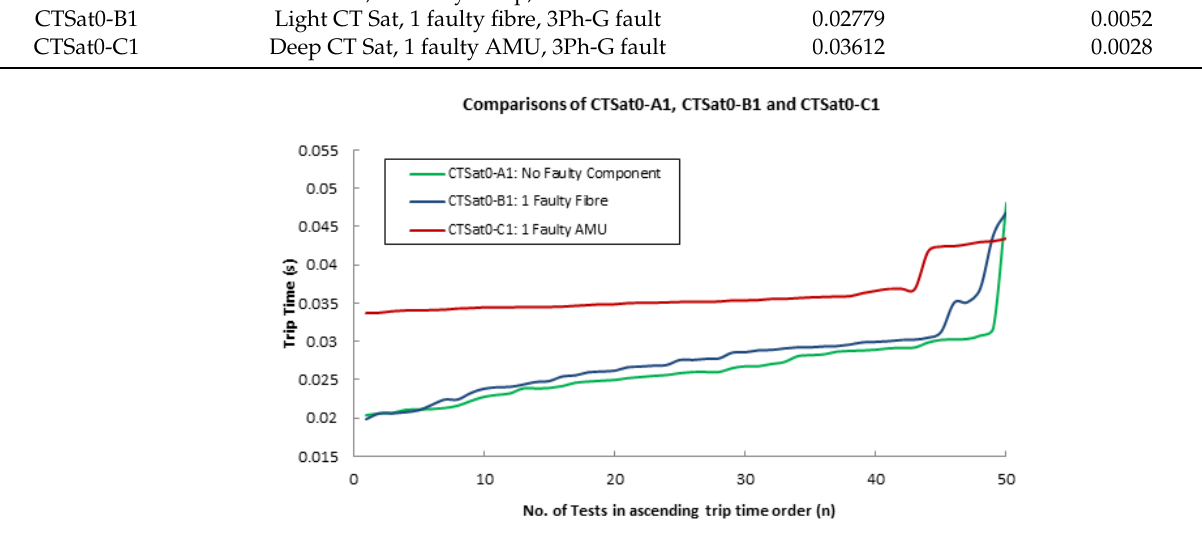
Figure 13. Comparisons for CTSat0-A1, CTSat0-B1 and CTSat0-C1 (ideal CT, no/one faulty compo- nent, 3Ph-G fault at 50% of the feeder).